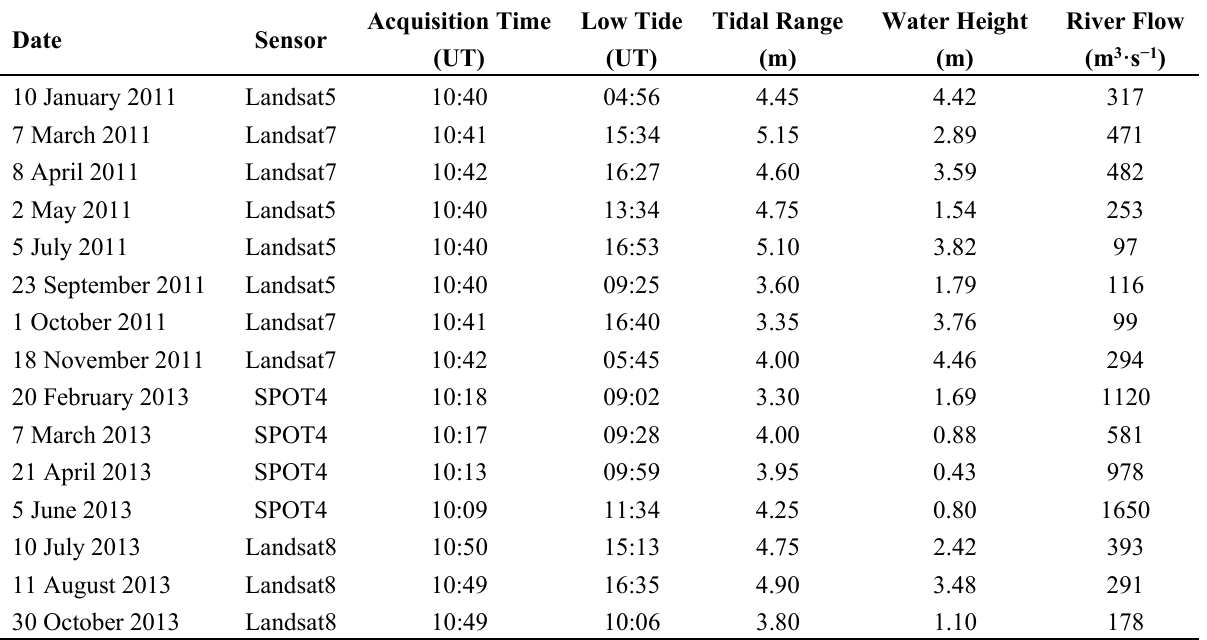
Table 2. List of selected satellite data for the Gironde estuary. Water height and tidal range provided by the SHOM at Bordeaux. River flow data measured at Tonneins, 100 km upstream of